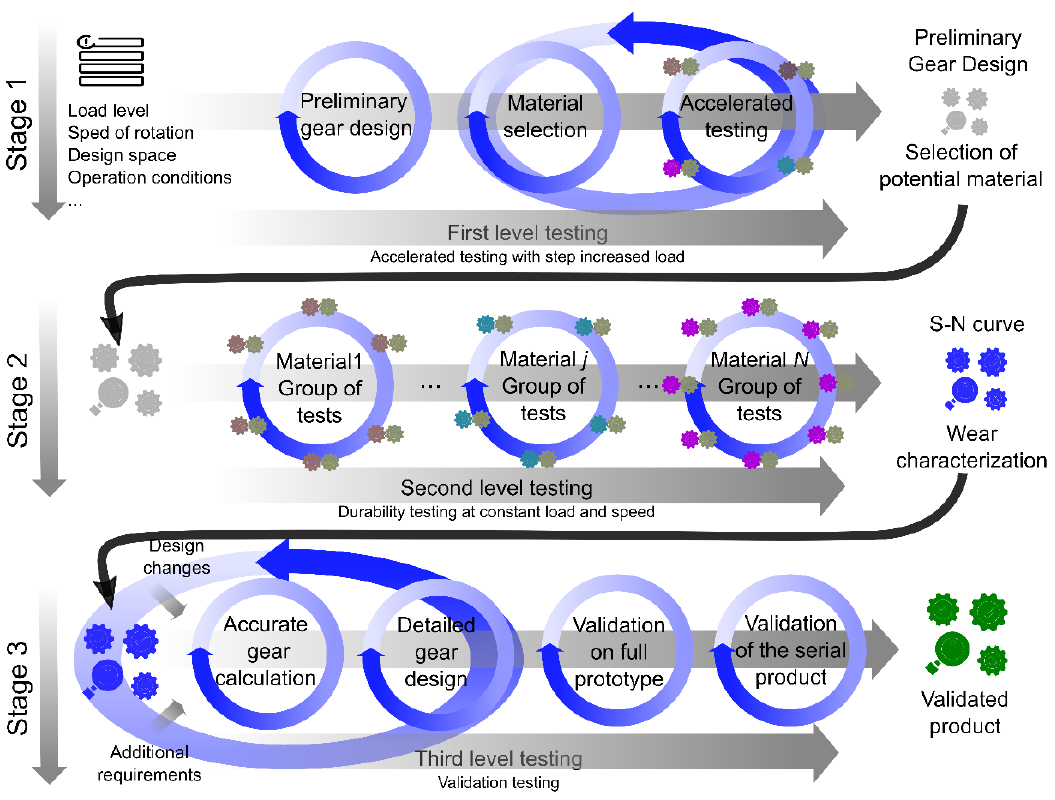
Figure 13. Accelerated polymer gear design procedure integrated in the Agile product development